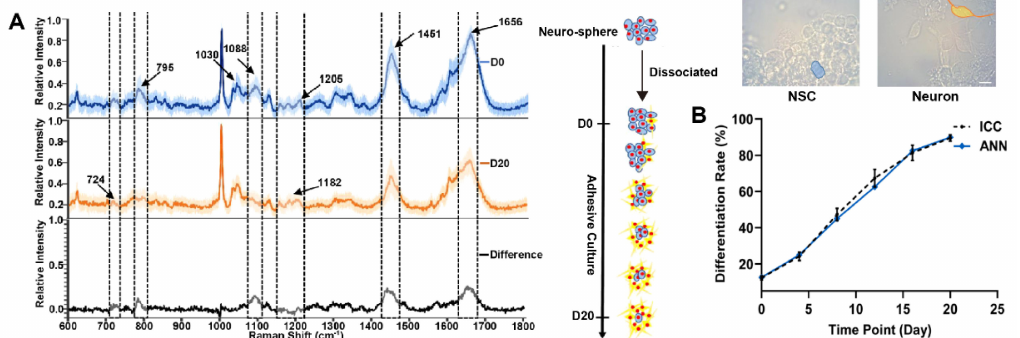
Figure 2. ( A ) Raman spectra of stem cells on day 0 (blue) and day 20 (yellow). The black spectrum shows differences. ( B ) Evaluation of differentiation rate using machine learning based on Raman spectra. Adapted with permission from Ref. [163]. Copyright 2021 American Chemical